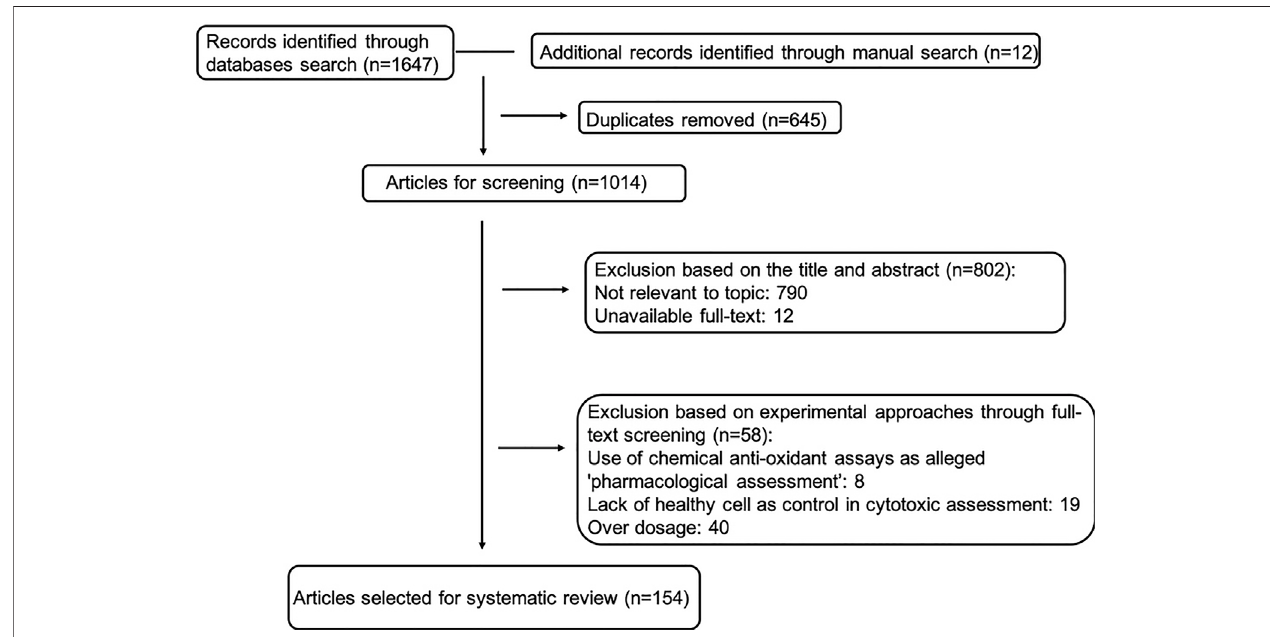
FIGURE 1 | Work fl ow chart of inclusion and exclusion of studies in the systematic review (exclusion based on experimental approaches may overlap, therefore selected article number is slightly different from simple subtraction).